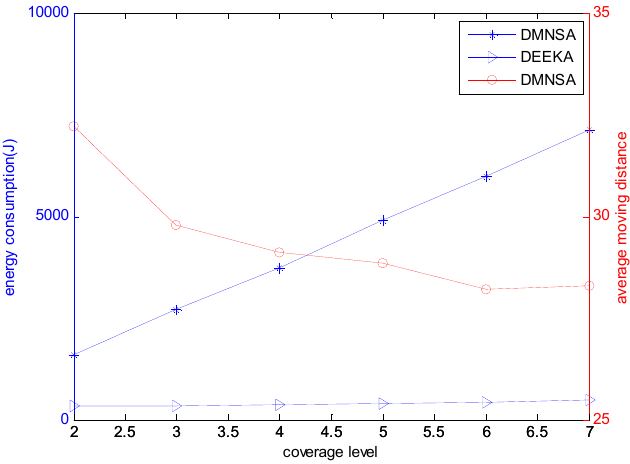
Figure 13. Energy consumption and average moving distance with varying K.